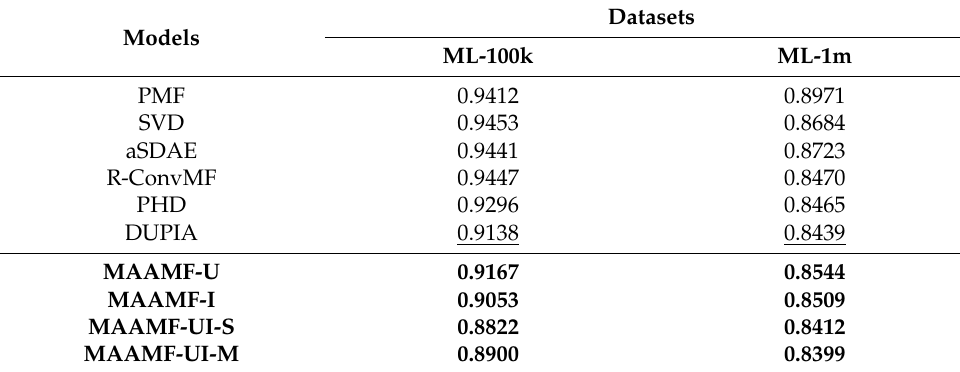
Table 5. RMSE result of different models in the two shared datasets. Results of the state-of-the-art models are underlined, and the optimal result of our model is marked in bold. Datasets Models ML-100k ML-1m PMF 0.9412 0.8971 SVD 0.9453 0.8684 aSDAE 0.9441 0.8723